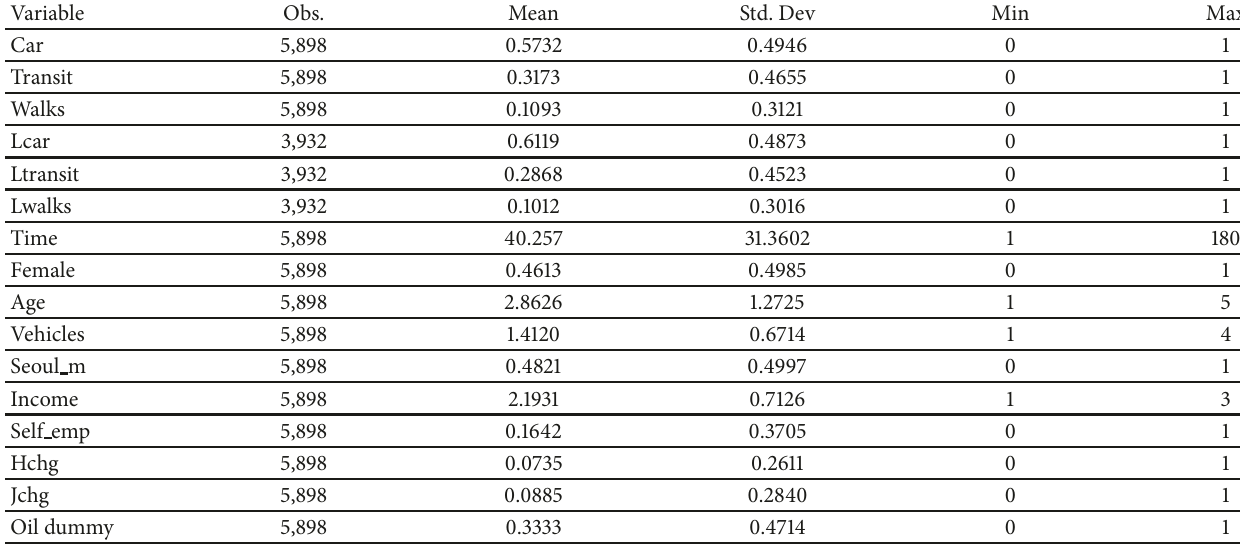
Table 2: Descriptive statistics of used variable.